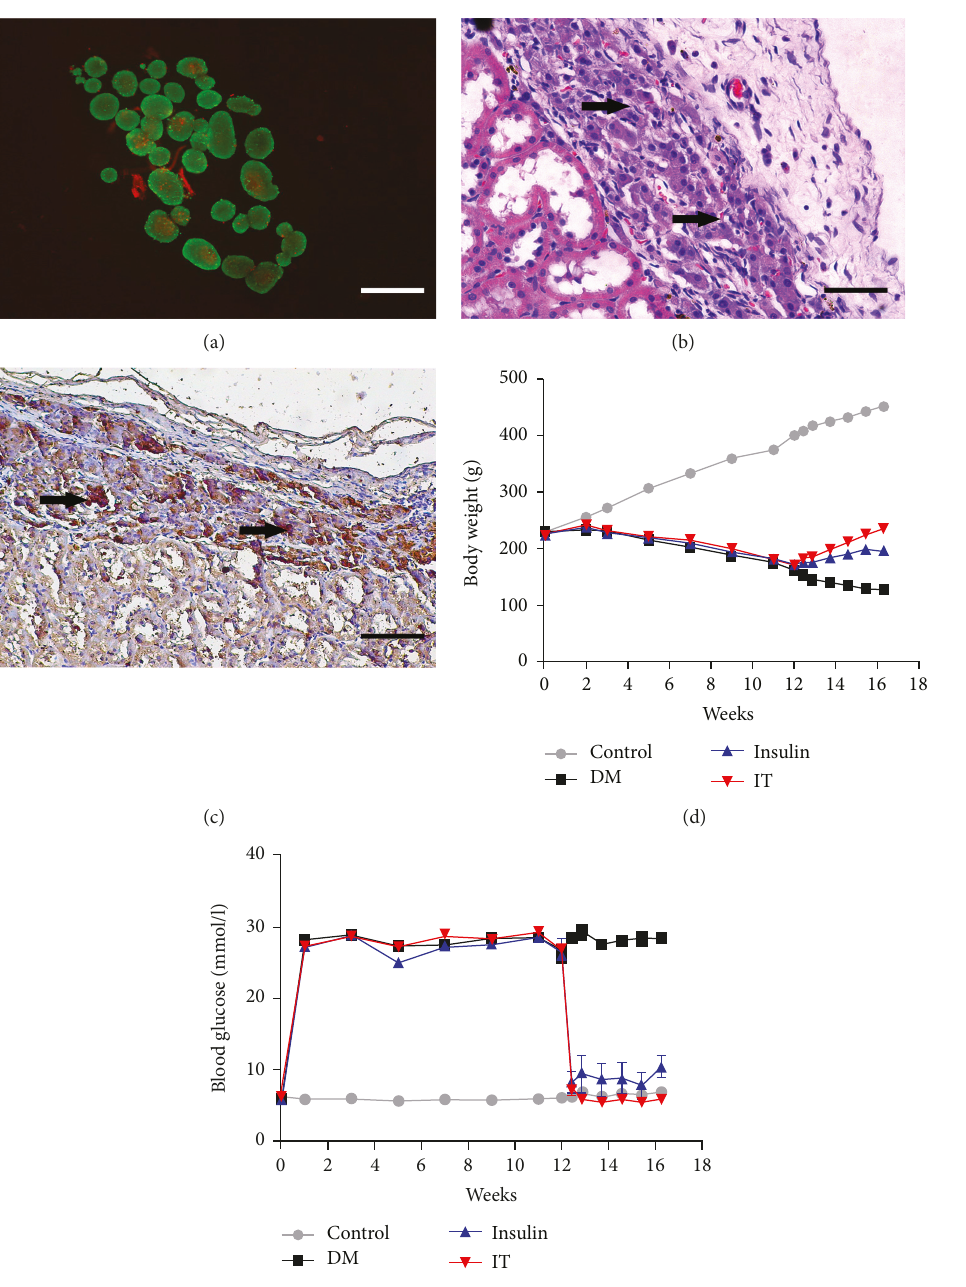
Figure 1: Evaluation of isolated islet viability and function and change in blood glucose in each group. (a) Viability evaluation of isolated islets (FDA-PI staining: × 200). Bar = 50 μ m . (b) Stable colonization of transplanted islets under the kidney capsule (HE staining: × 200). Bar = 50 μ m . (c) Massive release of insulin after transplantation (immunohistochemical staining: × 200). Bar = 50 μ m . (d) Body weight changes over 16 weeks for each group. (e) Rat blood glucose changes over 16 weeks for each group (islet transplantation model rats established at 12 weeks). DM: diabetes mellitus; INS: insulin treatment; IT: islet